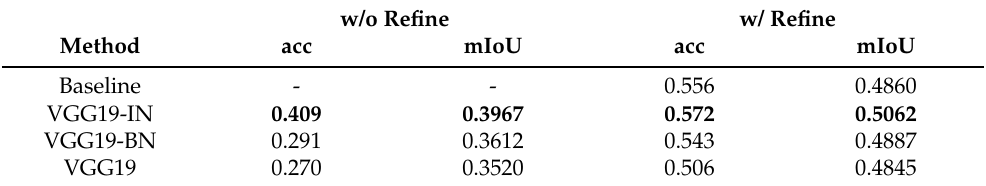
Table 2. Classification and segmentation evaluation of the ablation study: “w/o” and “w/ refine” refers to without and with search refinement,